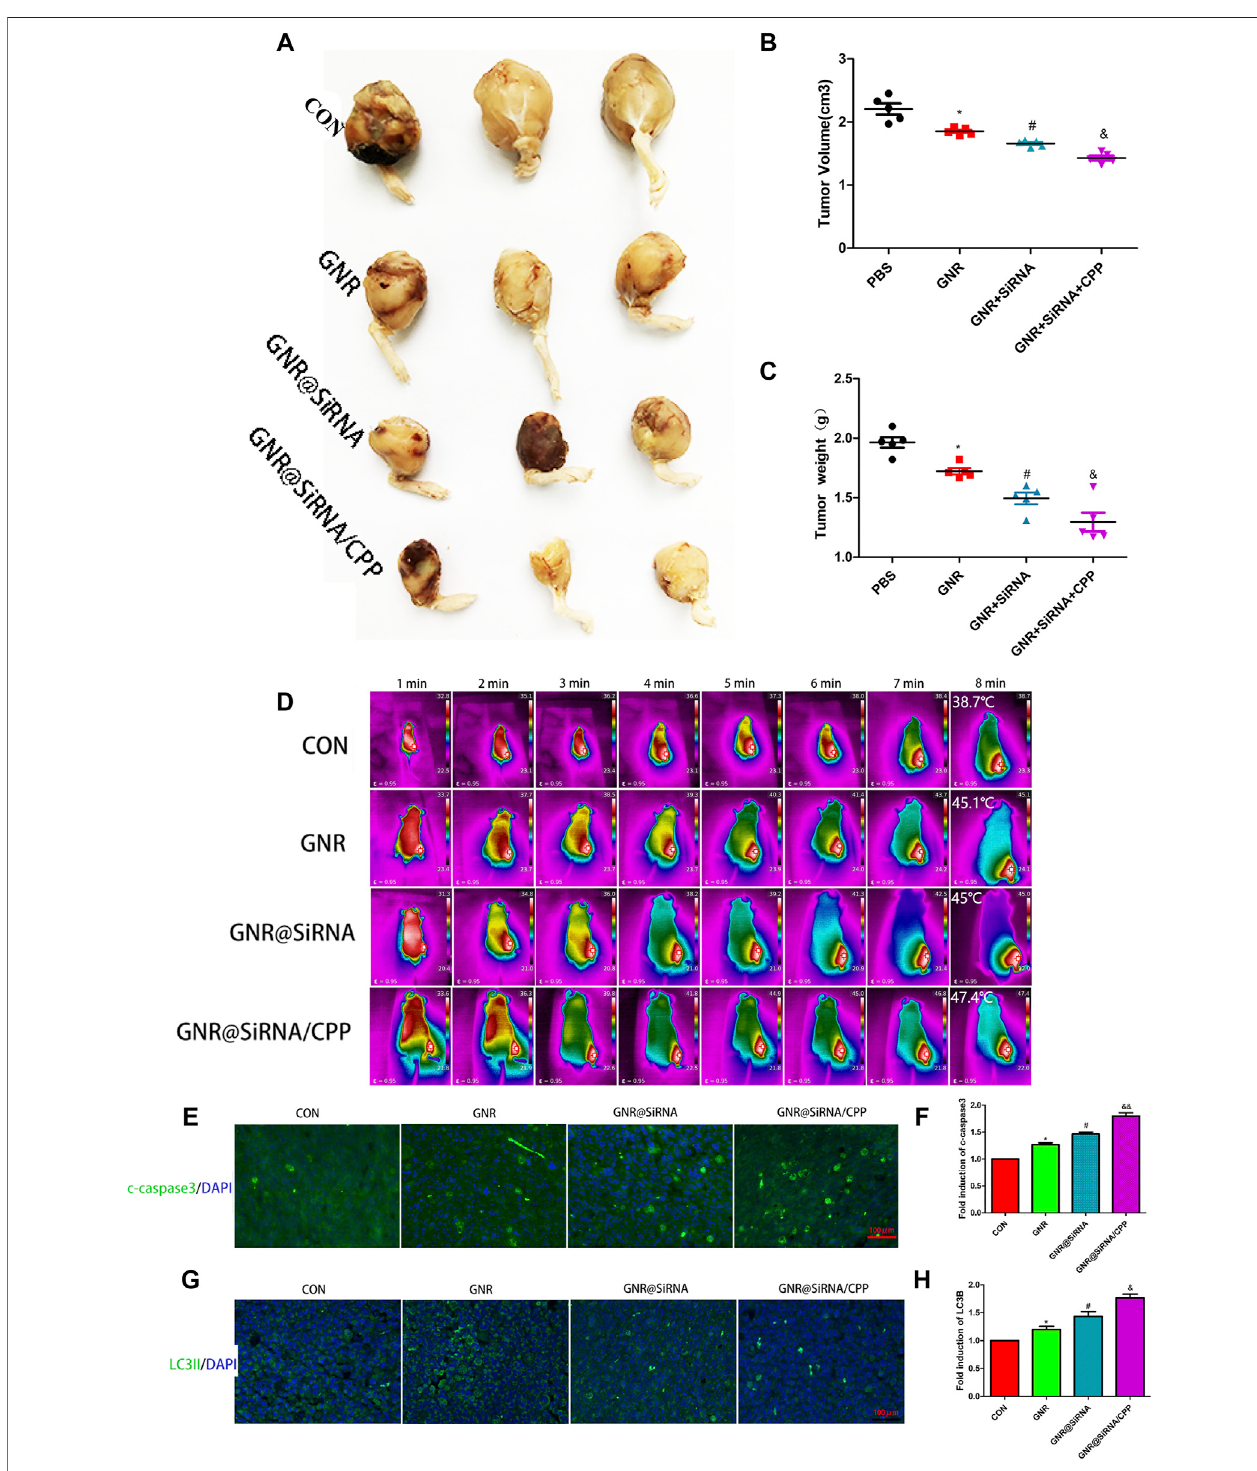
FIGURE 5 | Nanoplatforms inhibit the growth of the marrow cavity of OS in vivo . (A – C) Photographs of harvested xenograft tumors in different groups. (D) ThermographsofmicerecordedindifferentgroupsbyNIRirradiationforvarioustimes. (E – H) Immuno fl uorescencestainingofc-caspase3andLC3Bindifferentgroups. ( n (cid:2) 5 per group; * p < 0.05 vs. CON group; # p < 0.05 vs. GNR group; & p < 0.05 or && p < 0.01 vs. GNR@siRNA group).